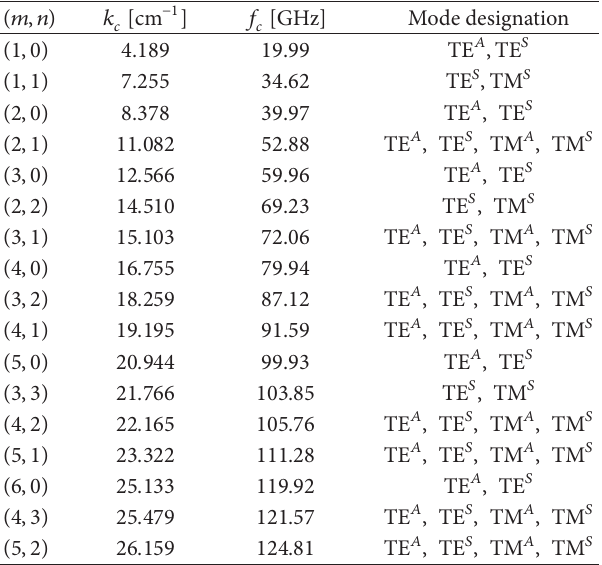
Table 1: Cut-off wavenumbers, cut-off frequencies, and associated families for the first fifty modes in a hollow equilateral triangular waveguide of side 𝑒 = 1